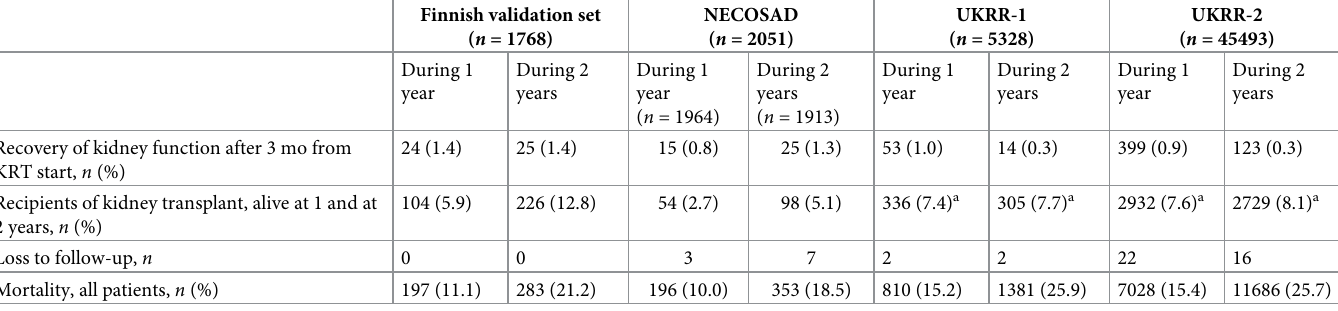
Table 3. Outcome according to data set.